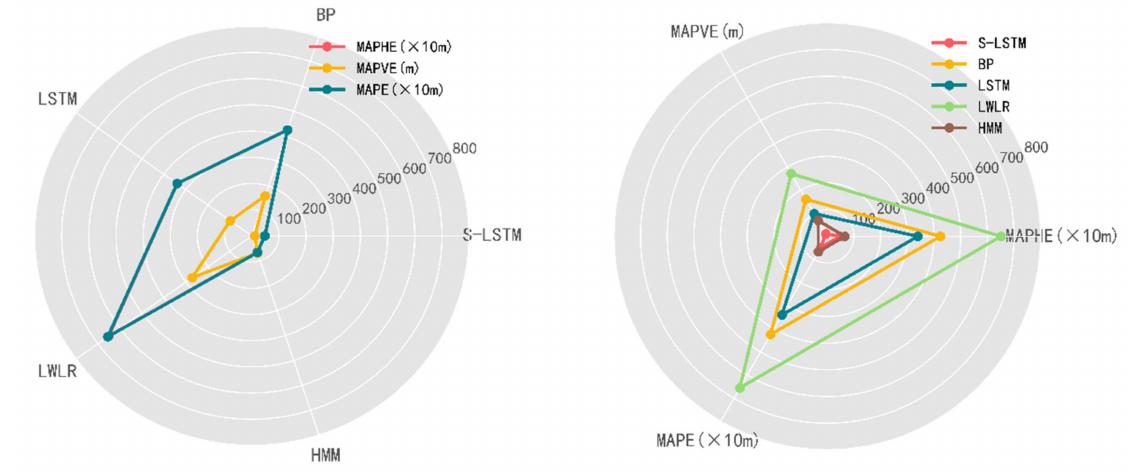
Figure 9. Radar chart of predicting errors for departure